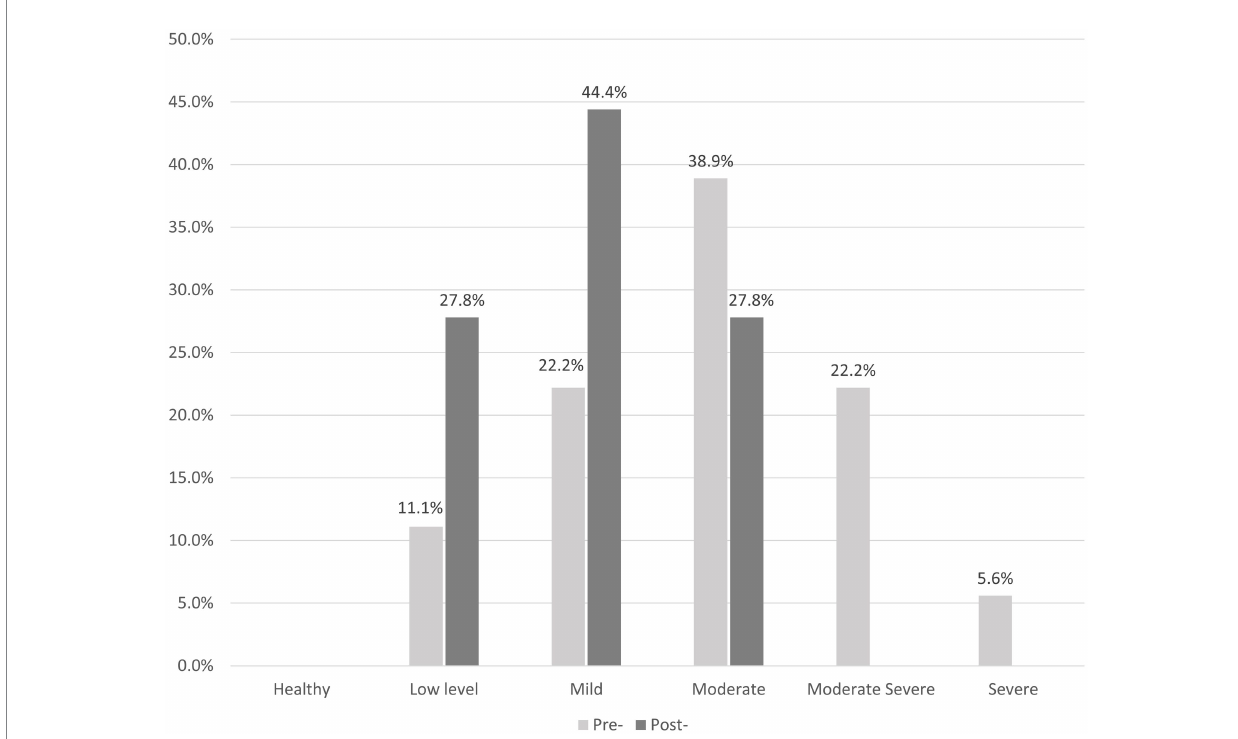
FIGURE 1 Pre- and post-intervention levels of symptoms and distress, based on CORE-OM clinical